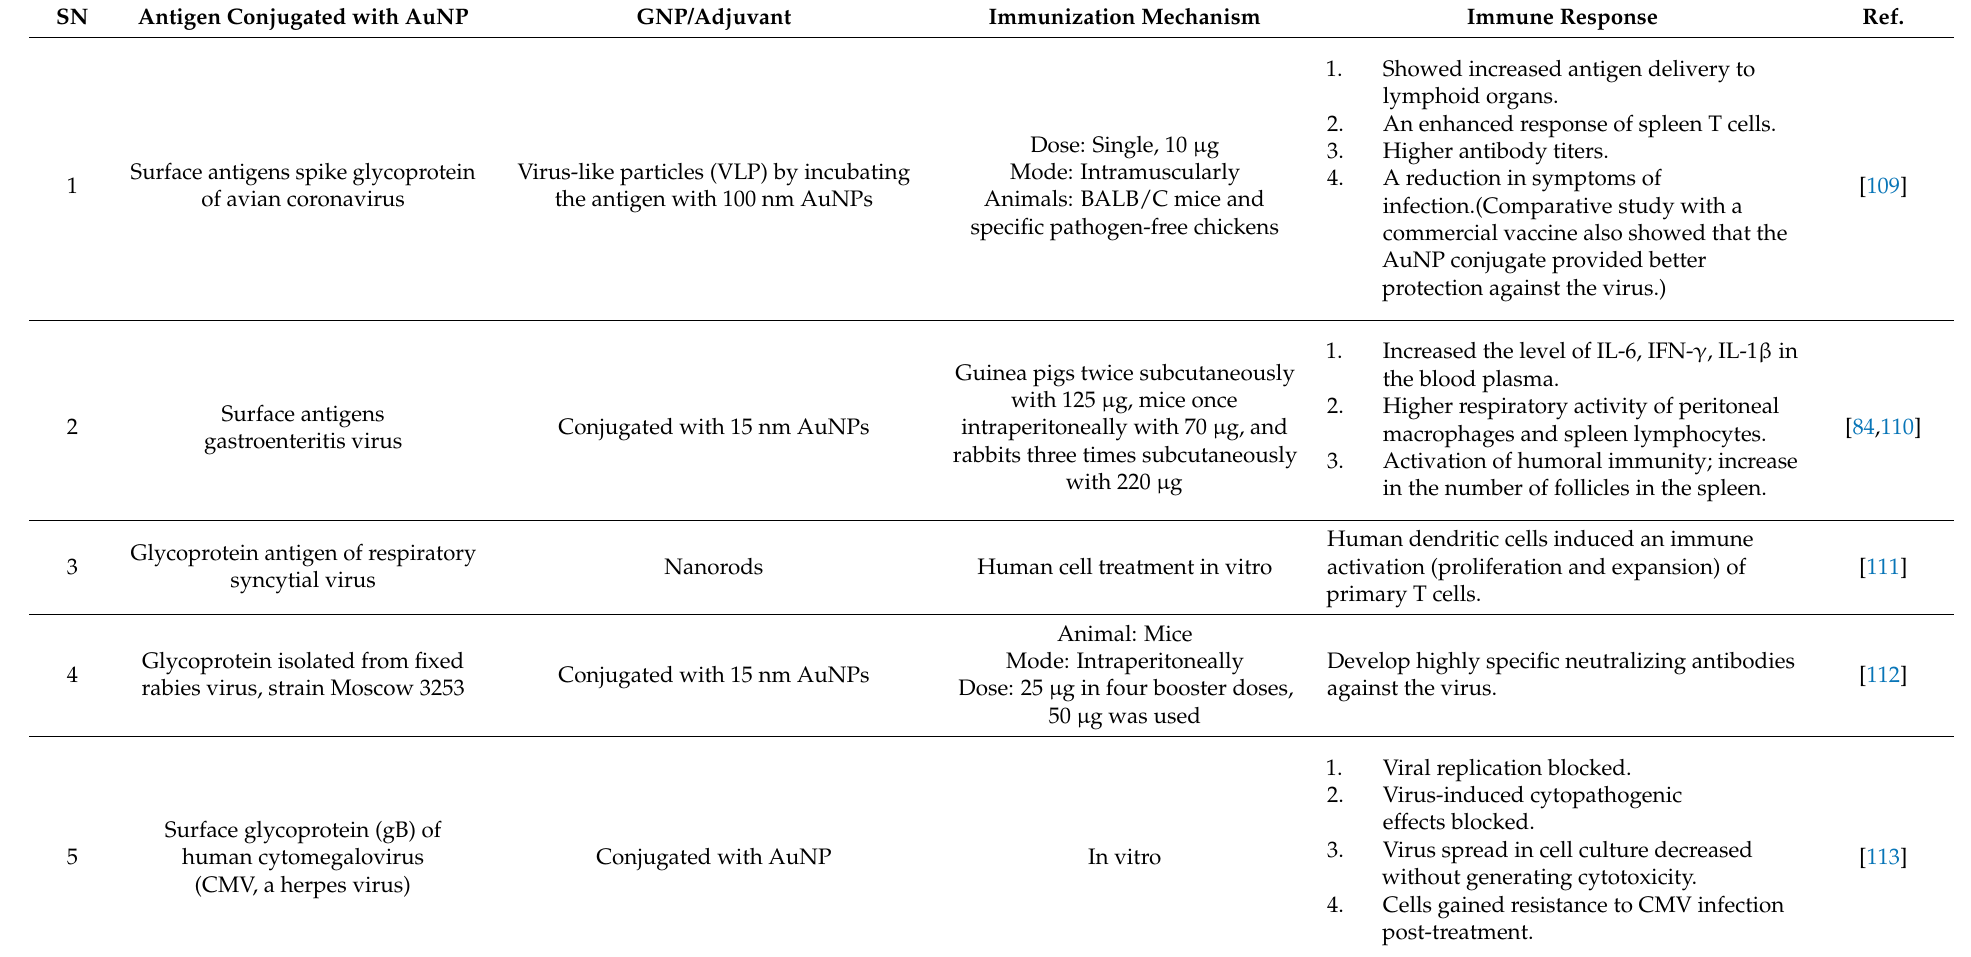
Table 1. Use of GNP based nanovaccine against viral